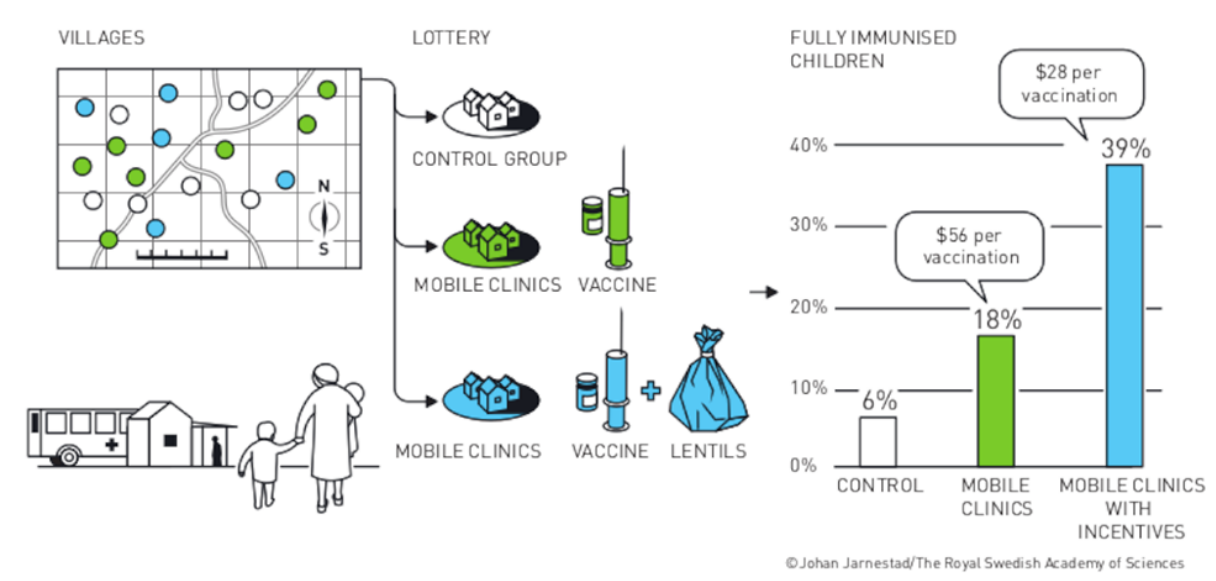
Figure 1 - Randomized trial for vaccine uptake in rural